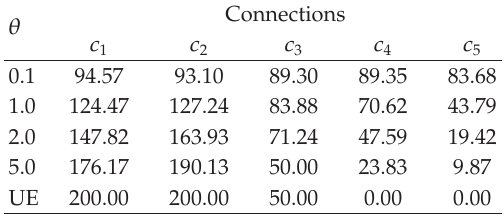
Table 2: The resultant connection flows for various θ in comparison with UE result, in persons.